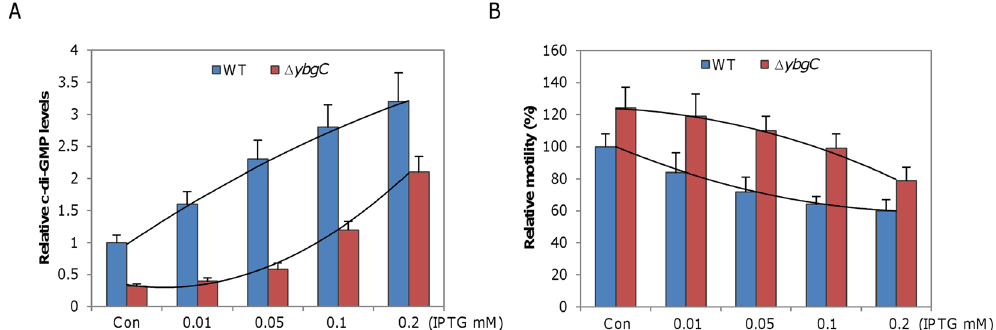
Figure 6. So YbgC-mediated regulation of motility functions through c-di-GMP. ( A ) Relative intracellular levels of c-di-GMP measured by LC-MS/MS. P. fluorescens WspR R129C , a constitutive active c-di-GMP synthetase, under P tac was expressed in the wild-type and ∆ ybgC strains in the presence of IPTG at indicated levels. The levels of c-di-GMP in WT carrying the empty vector were set to 1. ( B ) Relative motility. Motilities of the strains cultivated under the same condition as in A were compared. In both A and B , a second-order polynomial best fit for each strain is given and con represents the experimental condition that both strains carry the empty